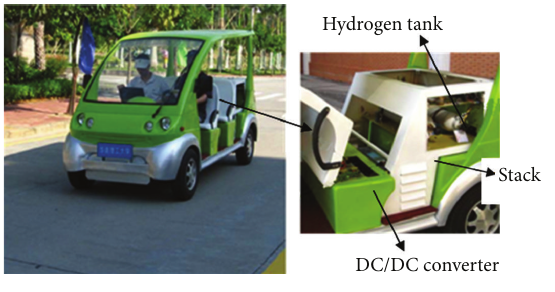
Figure 4: Vehicle test.